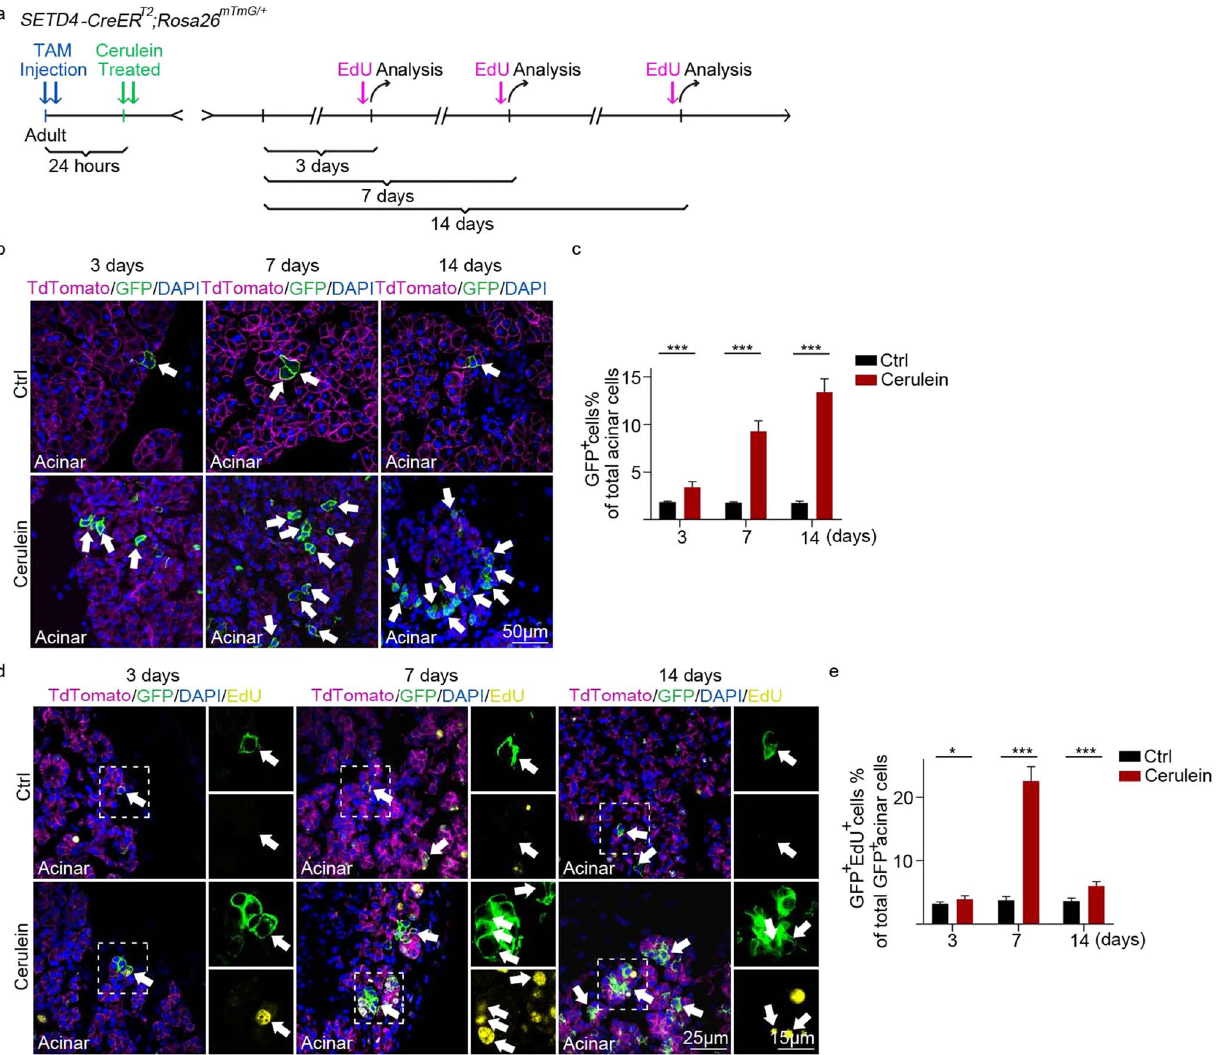
Figure 4. Lineage tracing of SETD4 + cells after cerulein-induced injury. ( a ) Experimental outline of lineage tracing of SETD4 + cells in adult SETD4-CreER T2 ; Rosa26 mTmG/ + mice after Cerulein-induced injury. 8–10 week mice were subjected to an episode of experimental chronic pancreatitis to induced chronic pancreatic damage at 24 h after TAM induction. Control mice received comparable injections of 0.9% saline buffer. Mice were sacrificed at the given times: 3, 7 and 14 days after Cerulein treatment. 5-ethynyl-2’-deoxyuridine (EdU) solution was injected into mice 2 h before each collected sample at each point in time. ( b ) Representative immunofluorescence for recombinant GFP + cells after 3, 7, or 14 days of Cerulein treatment and of Ctrls. Ctrl: Control. Scale bar for each image, 50 μm. ( c ) Quantification of GFP + cells in acinar compartment after 3, 7, or 14 days of Cerulein treatment and the Ctrl. Ctrl: Control. All data are represented as mean ± SD. *** p < 0.001. Ctrl: Saline buffer (n = 3 mice), Cerulein (n = 4 mice). ( d ) Representative immunofluorescence for EdU staining in the acinar compartment after 3, 7, or 14 days of treatment. Ctrl: Control. Scale bar for all merged images, 25 μm. Scale bar for all spilt images, 15 μm. ( e ) Quantification of GFP + EdU + cells in acinar compartment after 3, 7, or 14 days of treatment. Ctrl: Control. All data are represented as mean ± SD. * p < 0.05. *** p < 0.001. Ctrl: Saline buffer (n = 3 mice), Cerulein (n = 4 performed by conventional PCR on genomic DNA isolated from mouse-tails using standard procedures accord- ing to the instruction of Quick Genotyping Assay Kit for Mouse Tail (Beyotime, China D7283S). Tissue preparation. Mice were anaesthetized with 50 mg/kg pentobarbital sodium by intraperitoneal injection. The pancreas was collected and then fixed in 4% paraformaldehyde (PFA, Sigma P6148) at 4 °C, and washed in PBS extensively. For frozen sections, samples were dehydrated in 30% sucrose overnight at 4 °C, and embedded in optimal cutting temperature compound (Sakura #4583). For paraffin embedded sections, samples were dehydrated in gradient alcohol and then mounted in paraffin.